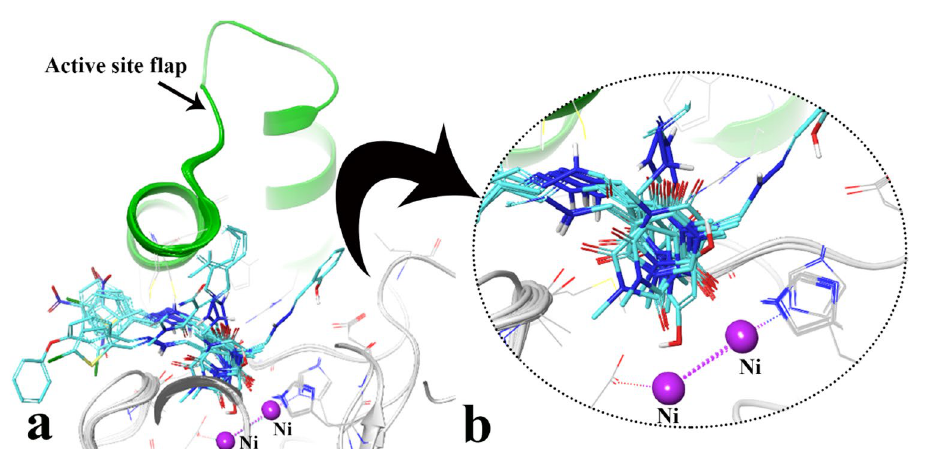
Figure 4. Representation of the compounds docking poses over the active site ( a ) close-up illustration of barbiturate ring relative to the bi-nuclear center ( b ), the active site flap colored in green color. The molecular graphic in this figure was generated using VMD